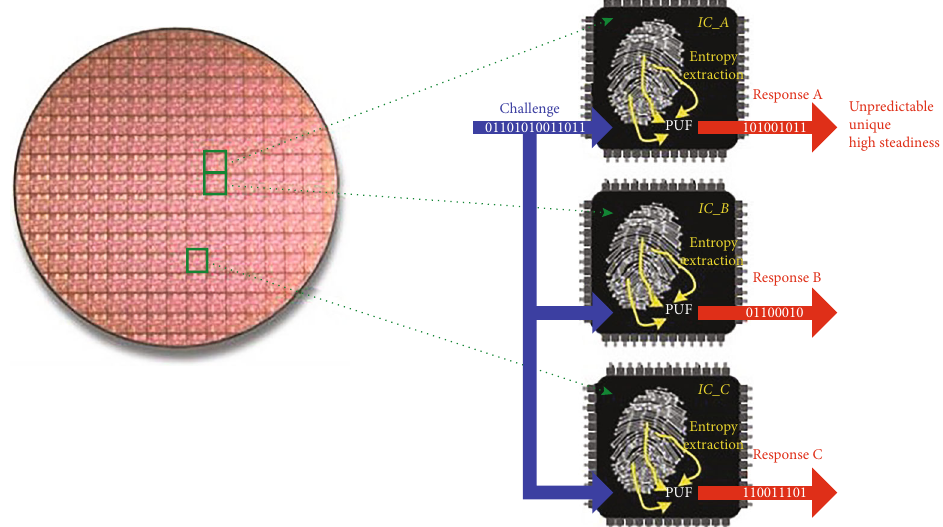
Figure 2: Responses to a challenge of di ff erent PUFs on di ff erent ICs